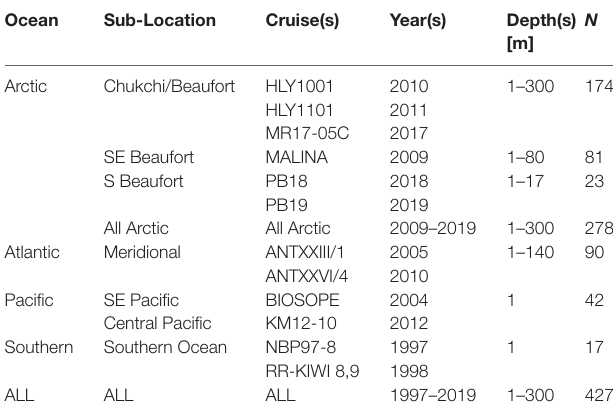
TABLE 1 | Summary of samples.